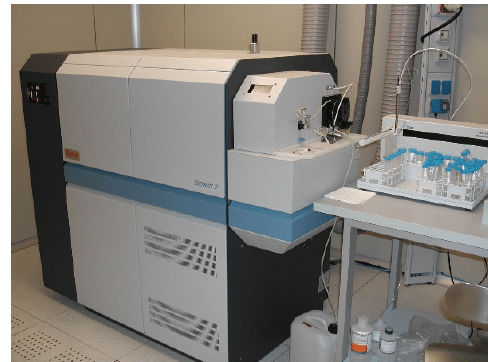
Figure 17: A small sample of the many facilities at universities and laboratories for screening materials before they are used in final construction of a dark matter exper- iment. Taken from [ 26 ]